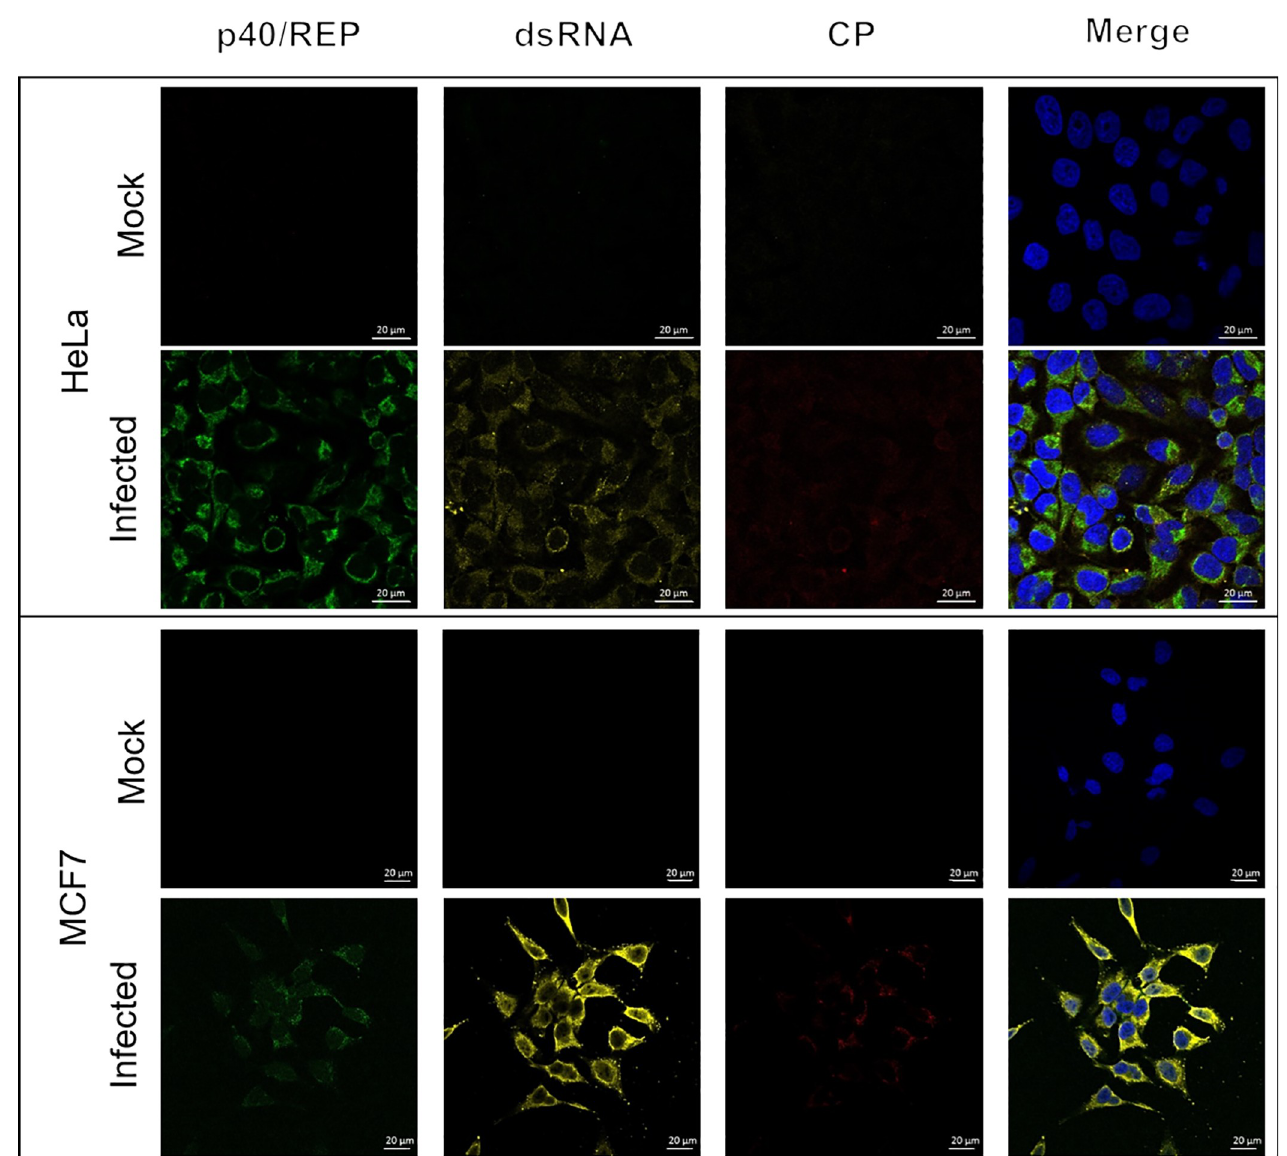
Fig 4. Infection of mammalian cells with PrV produced in cowpea plants. Human cervical (HeLa) and breast (MCF7) cancer cells were infected with PrV and subsequently analysed by immunofluorescence microscopy. Cells were probed with mouse monoclonal anti-dsRNA and anti-mouse AF546 [8]. Viral replicase was stained with biotin-conjugated p40 and streptavidin AF488, while rabbit polyclonal anti-CP and anti-rabbit AF633 were used to detect PrV CP. All images represent 1 μ m optical slices taken using a Zeiss LSM 780 laser scanning confocal microscope using a X63, 0.75 NA objective. Scale bar represents 20 μ